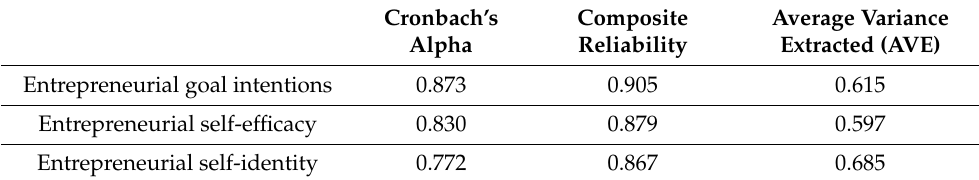
Table 1. Latent variables reliability and convergent validity.